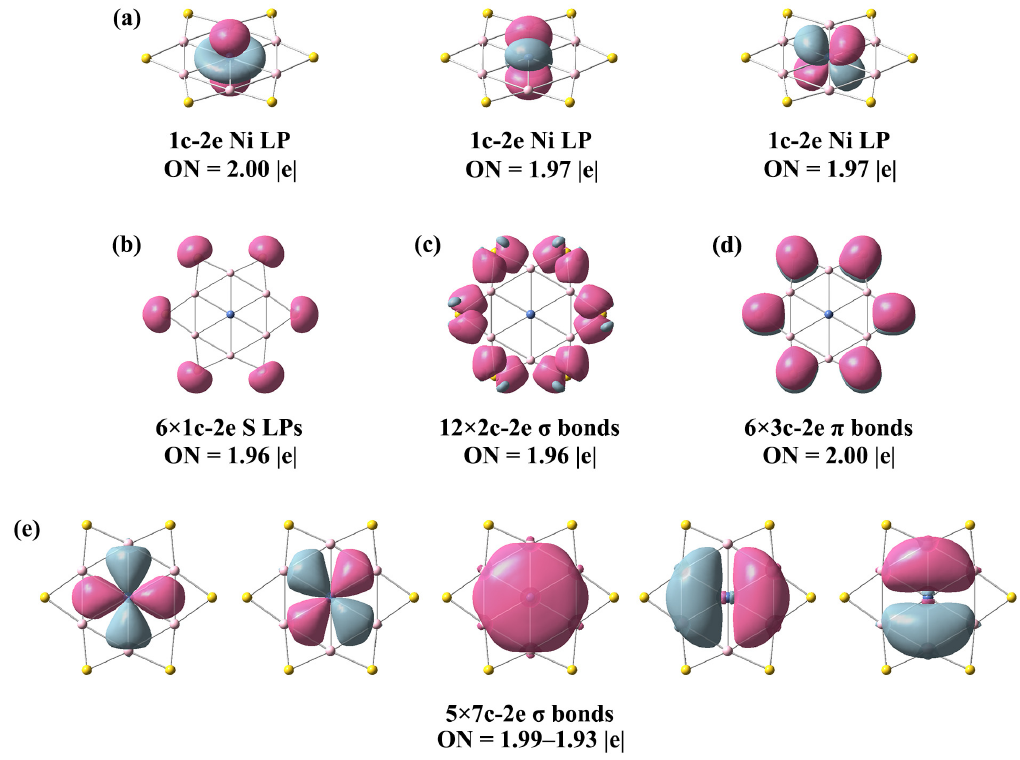
Figure 4. The AdNDP bonding pattern of 1 . Occupation numbers (ONs) are shown.